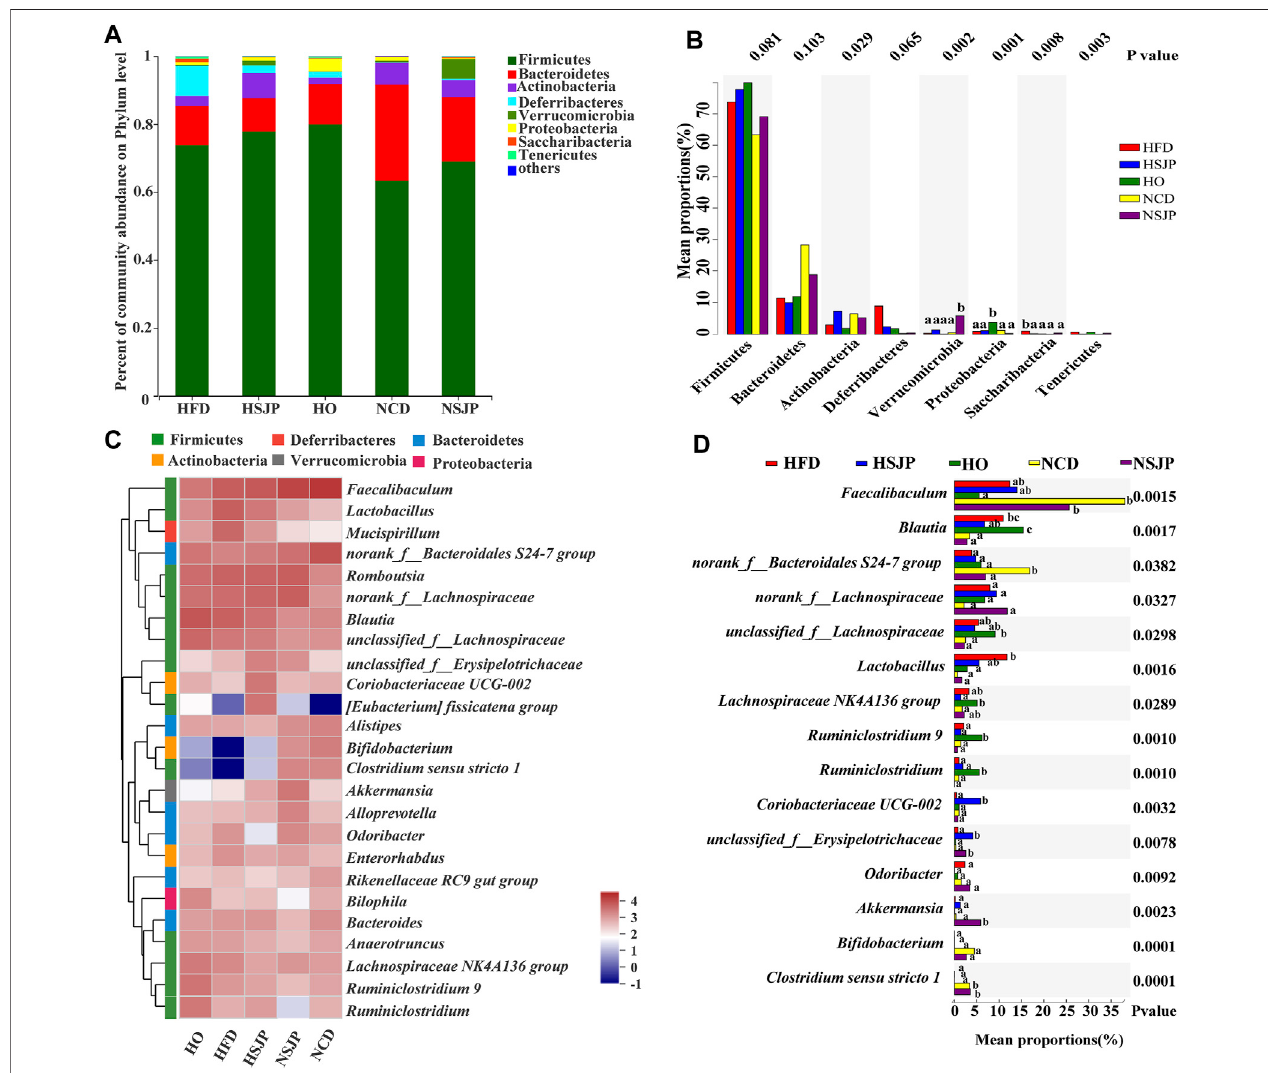
FIGURE 7 | Bacterial taxonomic structures of gut microbiota at the phylum and genus levels in different C57BL/6 mice groups. (A) Relative abundance of gut microbesatthephylumlevel.The y -axispresentsthemeanrelativeabundance. (C) Heatmapofthetop25genera. a,b,c Signi fi cantdifferencesamongmultiplegroupsat the (B) phylum and (D) genus levels were analyzed using Kruskal – Wallis tests with FDR correction ( p < 0.05). N (cid:2) 6 for each group. SJP, seaweed Laminaria japonica polysaccharides; FDR, false discovery rate.